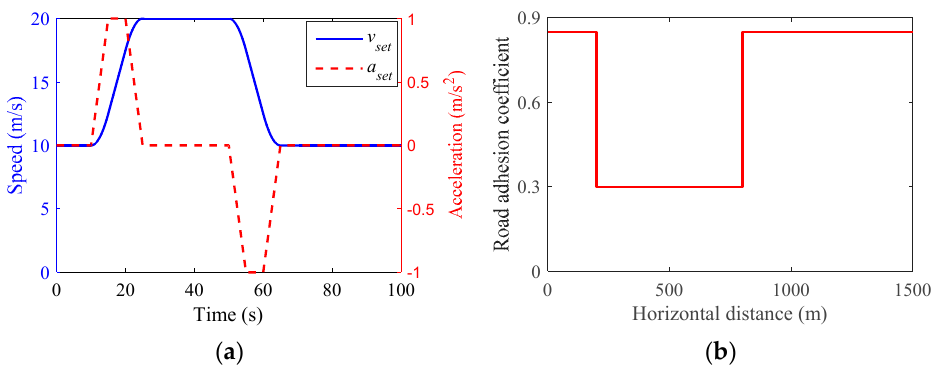
Figure 11. Profiles of leading vehicle movement and road adhesion coefficient in Scenario 3. ( a ) Leading vehicle movement. ( b ) Road adhesion coefficient.